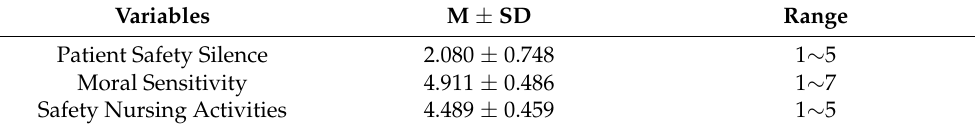
Table 2. The levels of patient safety silence, moral sensitivity, safety nursing activities (n = 120).